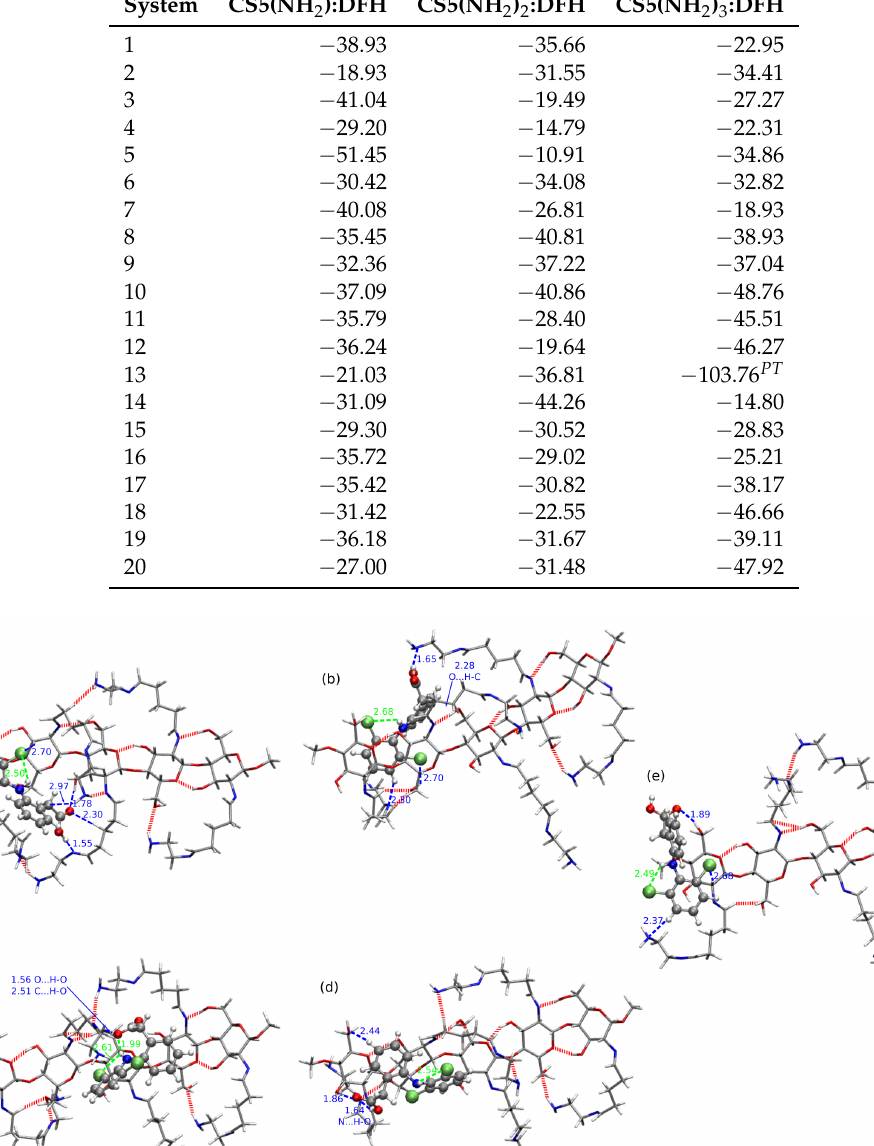
Table 3. B97-D3/6-311++G(d,p) supermolecular counterpoise-corrected interaction energy [kcal/mol] in CS5(NH 2 ) x :DFH complexes for x = 1,2,3. PT in superscript denoted the structure with intermolecular proton transfer.